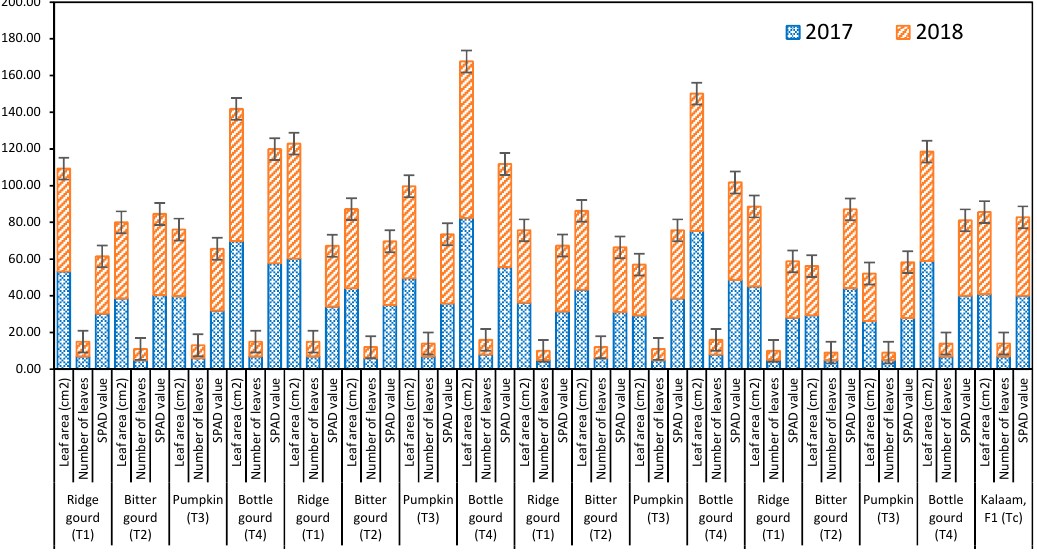
Figure 2. Evaluating the e ff ect of Scion / rootstocks combinations (grafting) on vegetative growth of Cucumber fruit after 30 days during crop season 2017 and 2018. Table 2 indicates plant mortality and the percentage of plant survival in the real rooted and grafted treatment of hybrid cucumber cv. Kalaam F 1 grafted on four local cucurbitaceous rootstocks (ridge gourd, bitter gourd, pumpkin and bottle gourd) with different grafting techniques during the 2017 and 2018 crop growing seasons. The statistical analysis presented in Table 2 shows that pumpkin rootstock in the hole insertion grafting method had a lower plant survival (42.00 ± 0.81 and 44.00 ± 1.29) in the 2017 and 2018 seasons respectively. These results showed unsuitability of hybrid Kalam F 1 with local rootstock. The significantly maximum plant survival rate of (96.00 ± 2.77) was obtained when grafted plants onto bottle gourd (T 4 ) in splice grafting during the first crop season, while in the second crop season bottle gourd (T 4 ) and ridge gourd (T 1 ) showed the same (95.00 ± 0.55) survival rates of grafted plants. Ridge gourd (T 1 ) and bitter gourd (T 2 ) in tongue grafting (G 1 ) and real rooted Kalaam, F 1 (T c ) didn’t show any significant difference during first growing season while, in second crop season ridge gourd (T 1 ) and bottle gourd (T 4 ) in tongue grafting (G 1 ) and non-grafted Kalaam, F 1 (T c ) didn’t show any significant difference in cucumber plants survival. The rootstocks under single cotyledon grafting method show significantly different results for plants survival. These results agreed with [54] who reported that the survival rate of cucumber plants increased under different grafting techniques. onto four local cucurbitaceous rootstocks with di ff erent grafting methods were presented in Figure 3. The bottle gourd rootstock had significant shoot length (cm) in tongue grafting (13.50, 13.30), splice grafting (12.20, 12.10) and single cotyledon grafting (11.34, 11.28) after first 15 days of grafting during 2017 and 2018 respectively while the hole insertion grafting showed non-significant results (4.15, 4.1) onto ridge gourd. The real rooted plant has (9.0, 9.20) shoot lengths. The plants with bottle